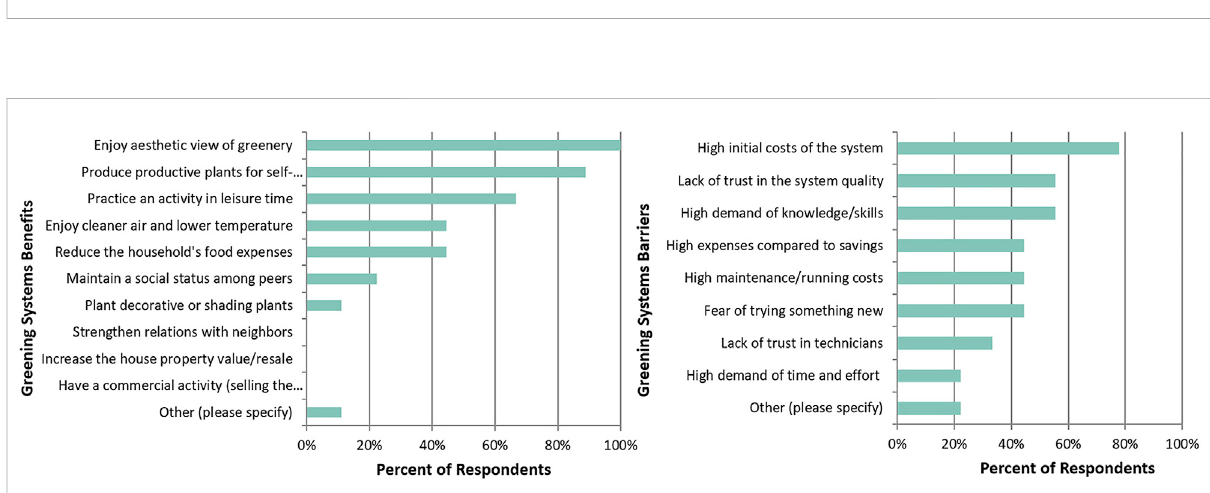
FIGURE 5 Resultsfromtheonlinesurveytargetinggreeningsystems ’ expertsandsuppliers.Itshowsthegreeningsystemsthatachievethehighestsalesin the Egyptian market based on the responses ( n = 15 out of 15 total respondents). Sales was de fi ned as the number of systems sold annually, and the respondents could select multiple options of systems (X = 41 total responses). NFT, Nutrient Film Technique; DWC, Deep Water Culture.